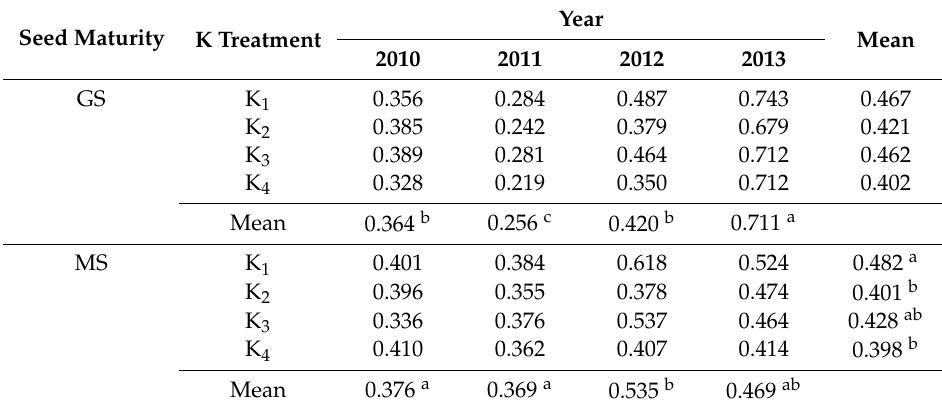
Table 4. E ff ect of years and K treatments on tannin content (mg kg − 1 ) in immature seeds (GS) and mature seeds (MS) of faba